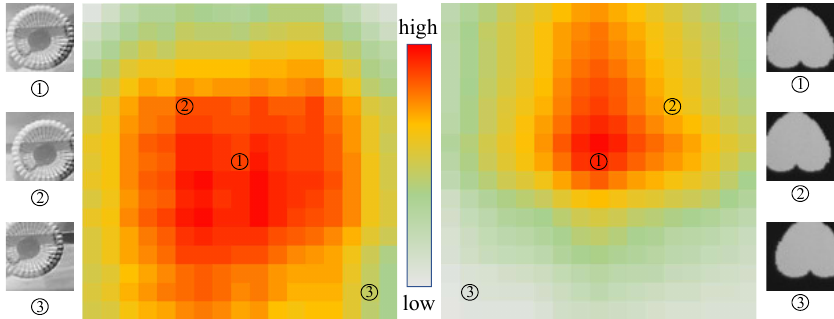
Figure 10. Salience trend as objects move away from the center of detection windows.